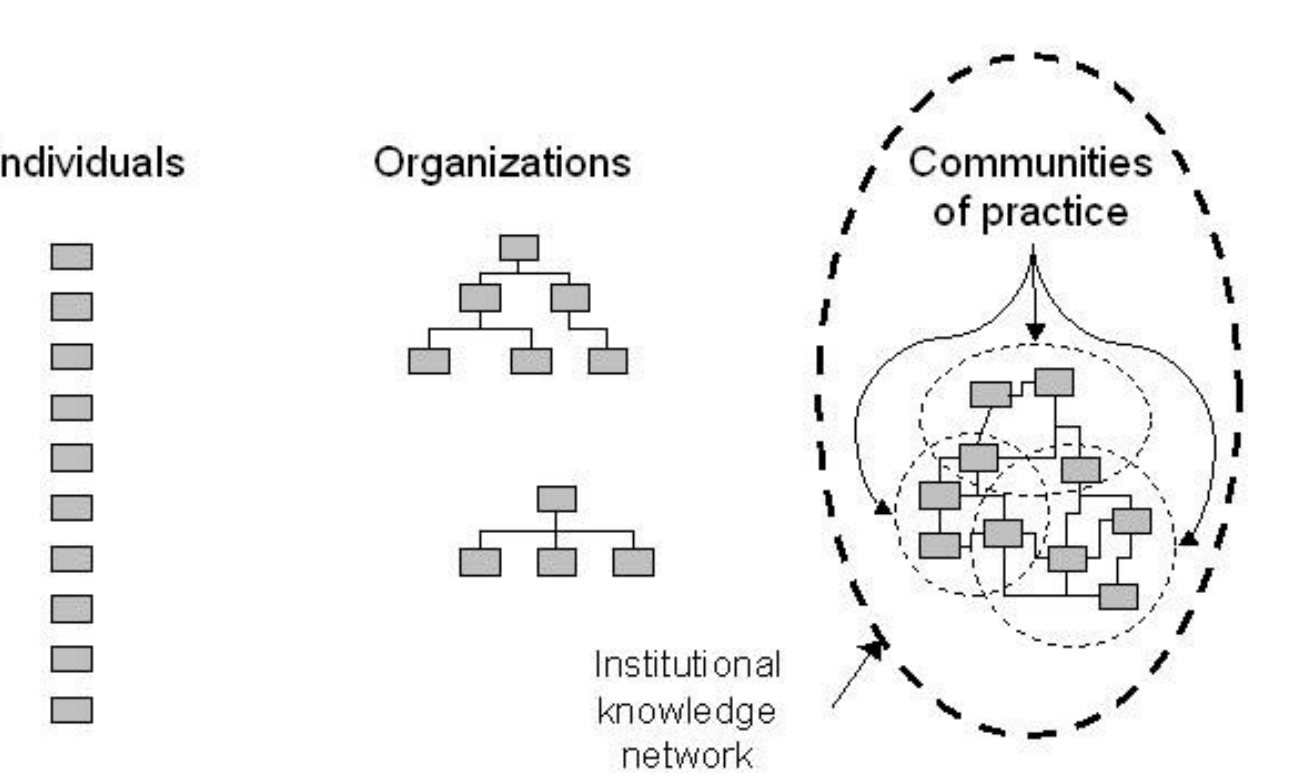
Fig. 4. Alternative configurations of people as basic knowledge units have implications for the degree of connectedness (lines) and associated sharing of knowledge. Overlapping communities within a bigger institutional knowledge network effectively connect people from government agencies, universities, science councils, conservation bodies, and the